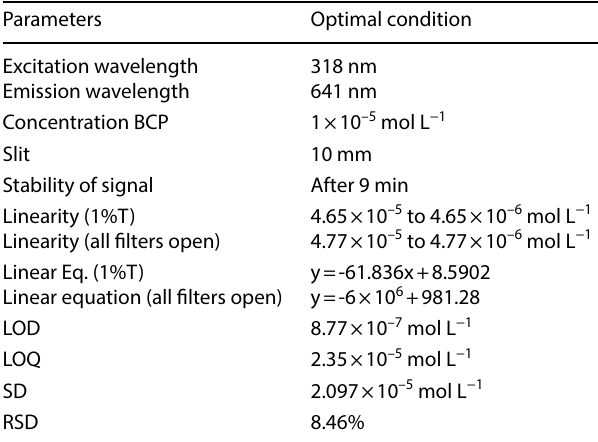
Table 2 Method analytical parameters Table 3 Accuracy assessment results for standard AA solutions